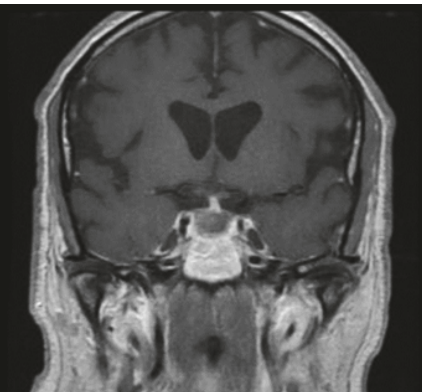
Figure 2: MRI (T1 weighted with contrast) one day after the surgery shows interval resection of the previously seen sellar mass/ hemorrhage and resolution of mass effect on the optic